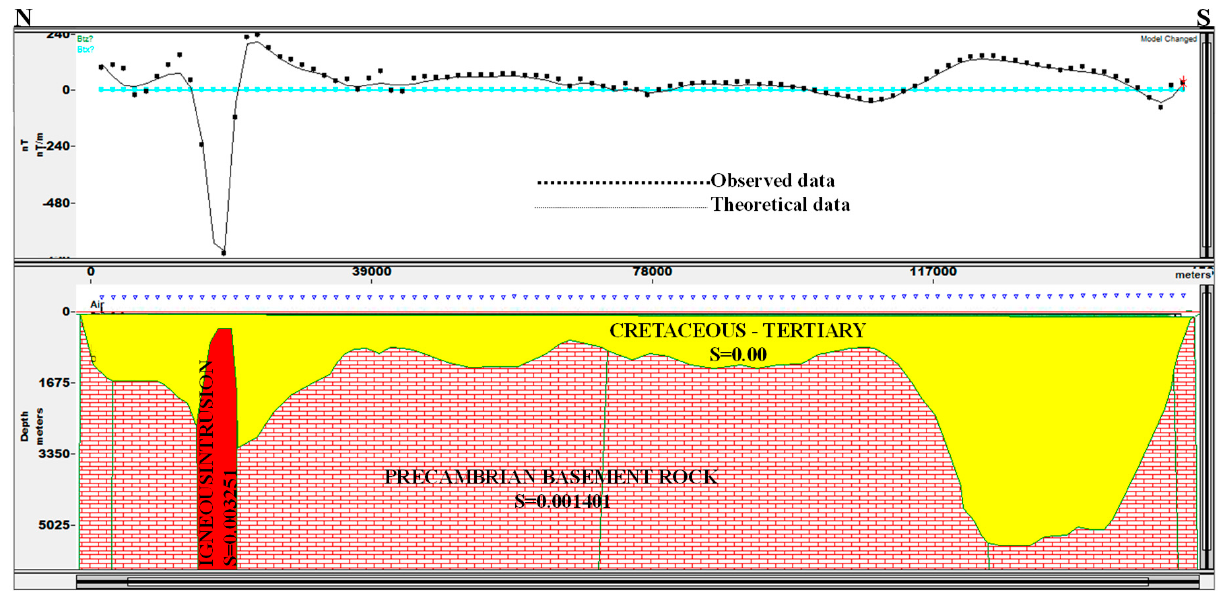
Figure 6. 2-D total magnetic intensity model obtained at Profile 2 showing thickness of sediments, basement and igneous rocks, and their respective susceptibility values.